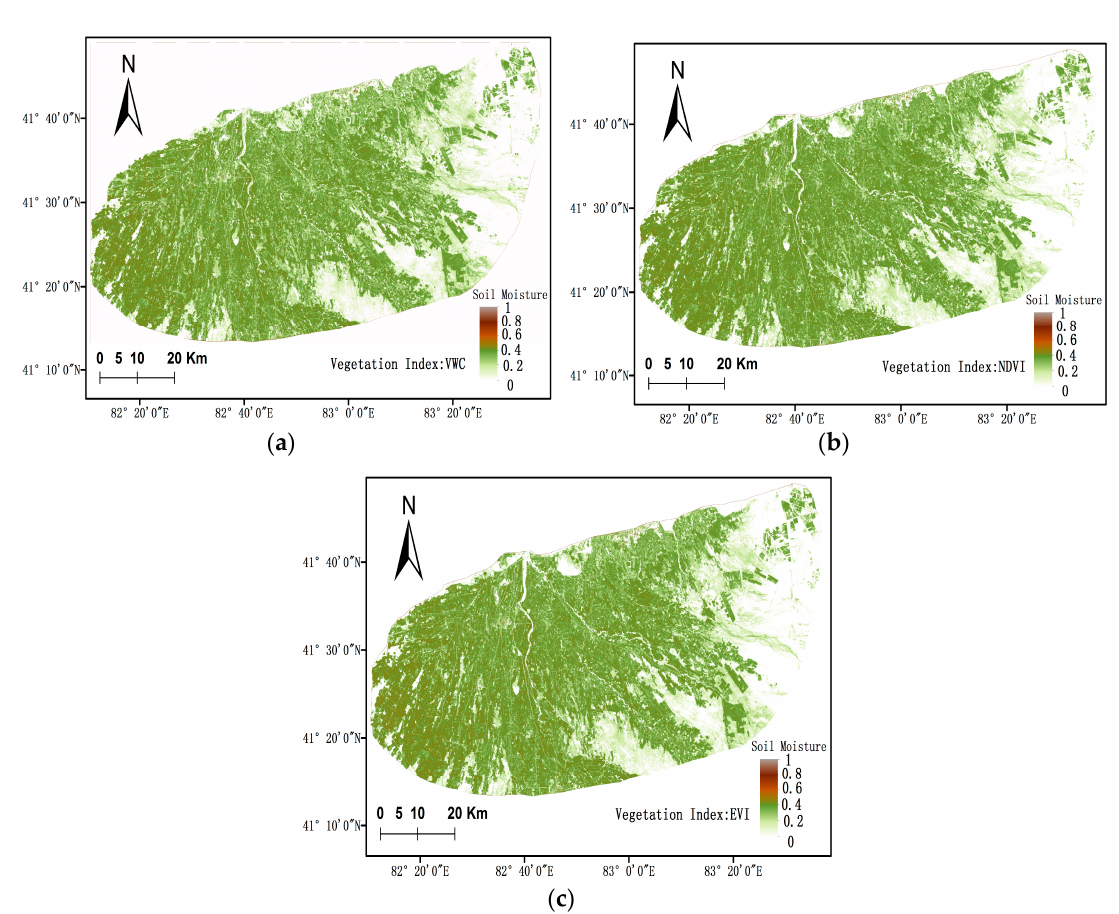
( b ) Figure 10. T he scatter plot of the backscattering coefficient of the Dubois model and in situ soil moisture ( a ) HH polarization ( b ) VV polarization. Figure 10 shows that there is a linear relationship between the backscattering coefficient simulated by the Dubois model and the in situ soil moisture. Therefore, we used a linear regression model to represent the functional relationship between the backscattering coefficient and soil moisture, which as shown in following equation 4. The unknown coefficient of the equation was solved and the results are shown in Table 4. The coefficient d represents the slope and the coefficient e represents the intercept. From Table 4, the regression equation can be concluded. The regression equation is 𝑚 (cid:3049) = 0.96 ∗ 𝜎 (cid:3035)(cid:3035)(cid:3046)(cid:3042)(cid:3036)(cid:3039)(cid:3042) + 30.18 under HH polarization, the regression equation is 𝑚 (cid:3049) = 0.92 ∗ 𝜎 (cid:3049)(cid:3049)(cid:3046)(cid:3042)(cid:3036)(cid:3039)(cid:3042) + 23.72 under VV polarization. As shown in Table 4, it can be found that the empirical relationship between the two polarizations and soil moisture are basically the same. Table 4. The unknown coefficient of empirical model. d